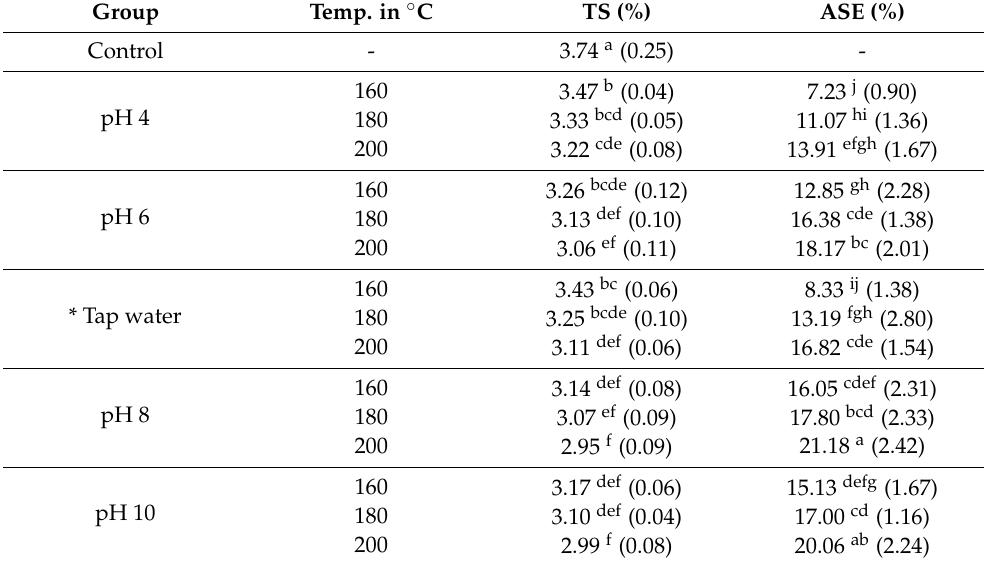
Table 7. Thickness swelling (TS) and anti-swelling efficiency (ASE) of treated and untreated samples of